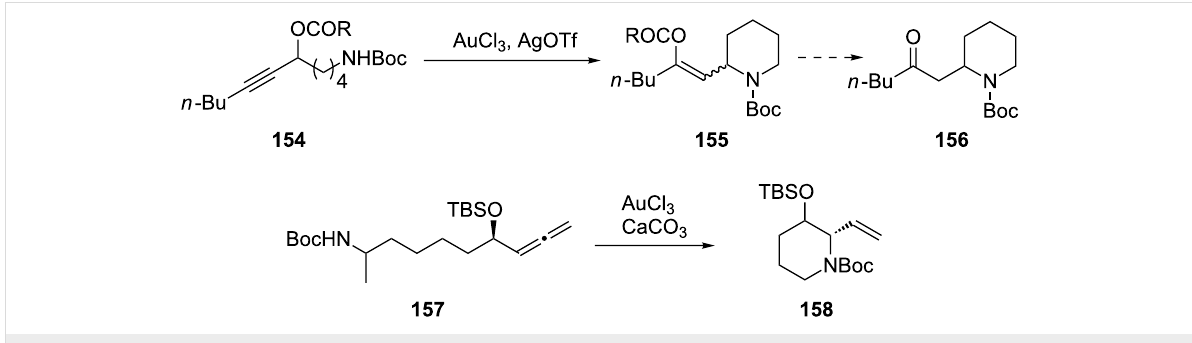
Scheme 27: Gold-catalyzed piperidine ring synthesis.